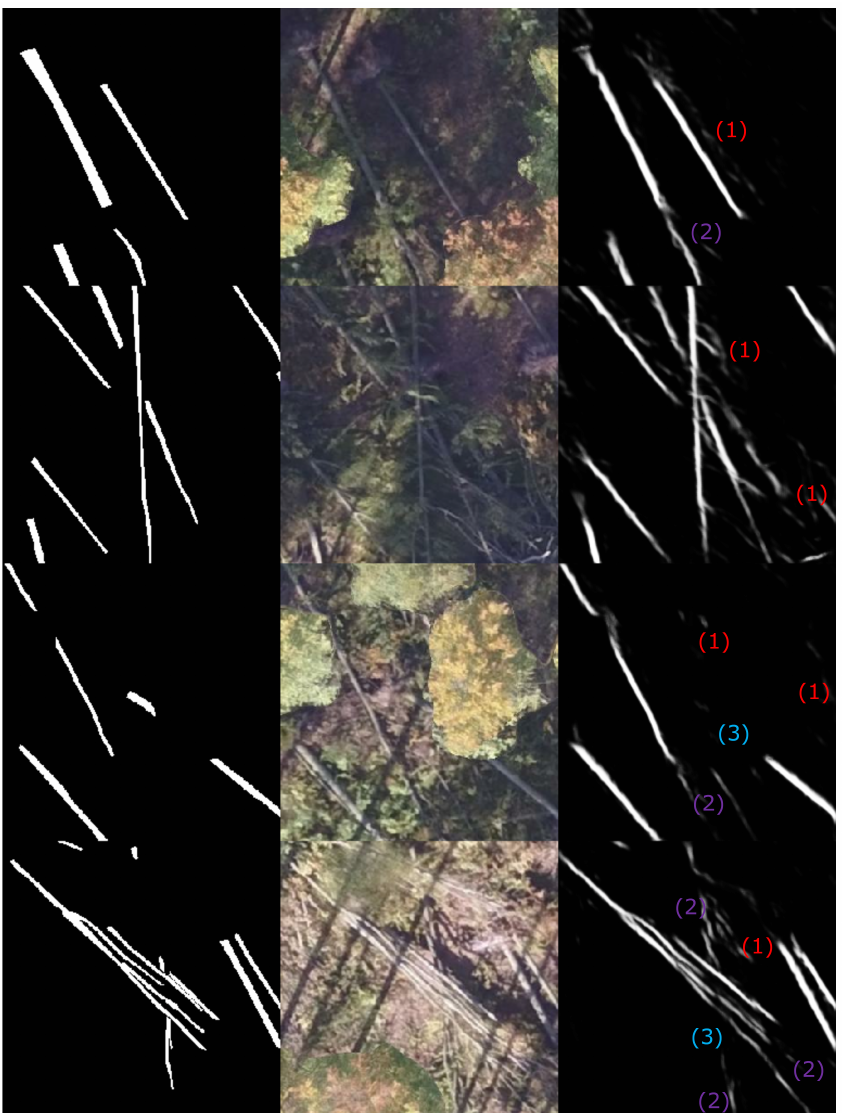
Figure 7. Baseline: predicted samples of the test dataset; left: tree mask; middle: test samples; right: predicted result. In some parts of the image, leaves and shadows were predicted as stem pixels (1). Smaller stems and branches, which were not masked because they were partly covered by leaves, were also detected (2). Both effects resulted in a lower precision. Furthermore, there were parts of stems which were not detected